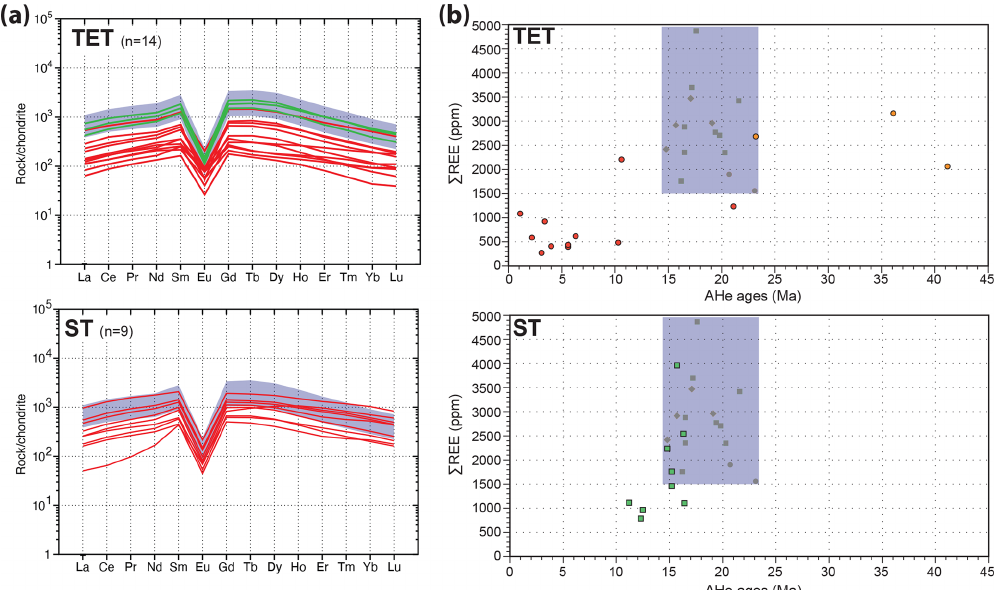
Figure 11. (a) Individual REE patterns of samples within the DZ for the TET and ST profiles; purple field: compositional field of samples outside the DZ defined by 13 REE spectra (gneiss samples TET5, ST4, ST8, and PLA2). For the TET profile, samples from the inner DZ (green) and outer DZ (red) are distinguished. (b) Sum of REE contents as a function of AHe ages. The purple field corresponds to REE contents from samples outside the DZ. The REE depletion is associated with a rejuvenation of AHe